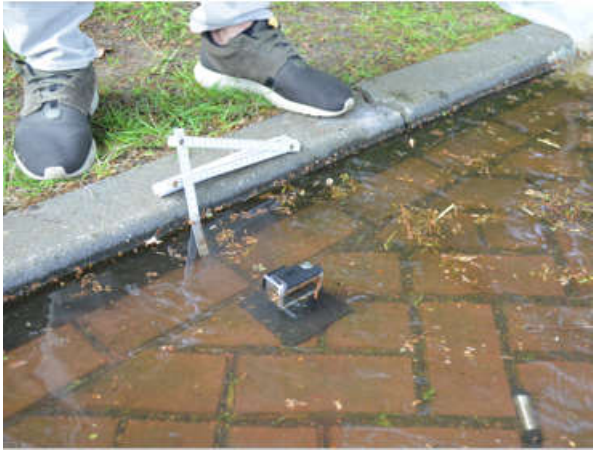
Figure 6. Minidiver installed; hand measurement point; underwater camera set-up.